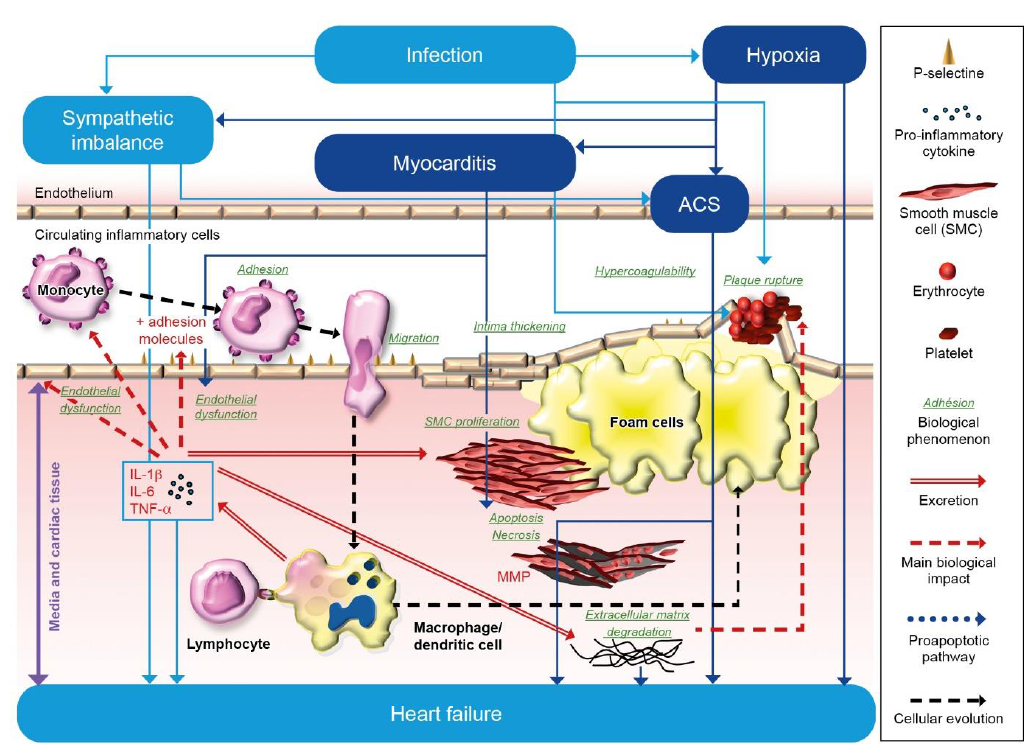
Figure 1. The mechanisms of the adverse effects of infection on heart failure.